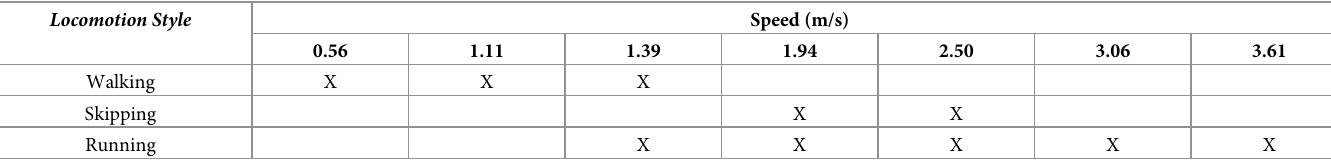
PLOS ONE | https://doi.org/10.1371/journal.pone.0278051 November23,